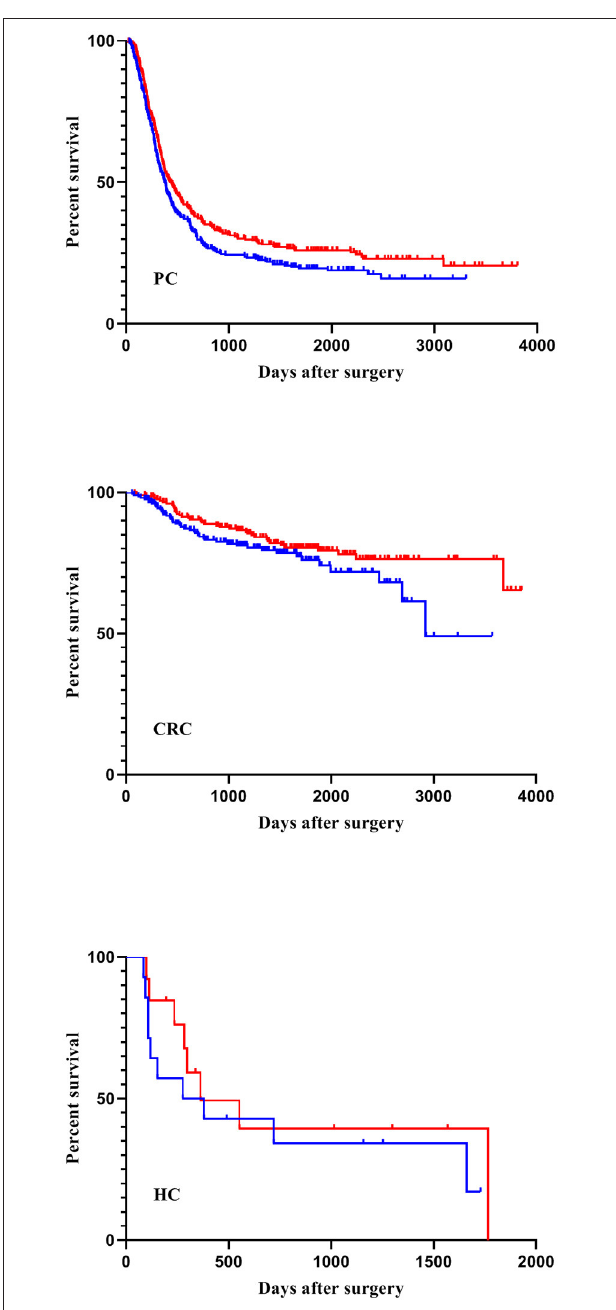
FIGURE 5 | FiO 2 and recurrence-free survival stratified for tumor entities. Patients were divided into an entity-controlled low-FiO 2 group and entity-controlled high- FiO 2 group. A stratified log-rank test with entities as strata was performed ( p = 0.007). FiO 2 , Fraction of inspired oxygen; CRC, Colorectal cancer; PC, Pancreatic cancer; HC, Hepatic cancer.